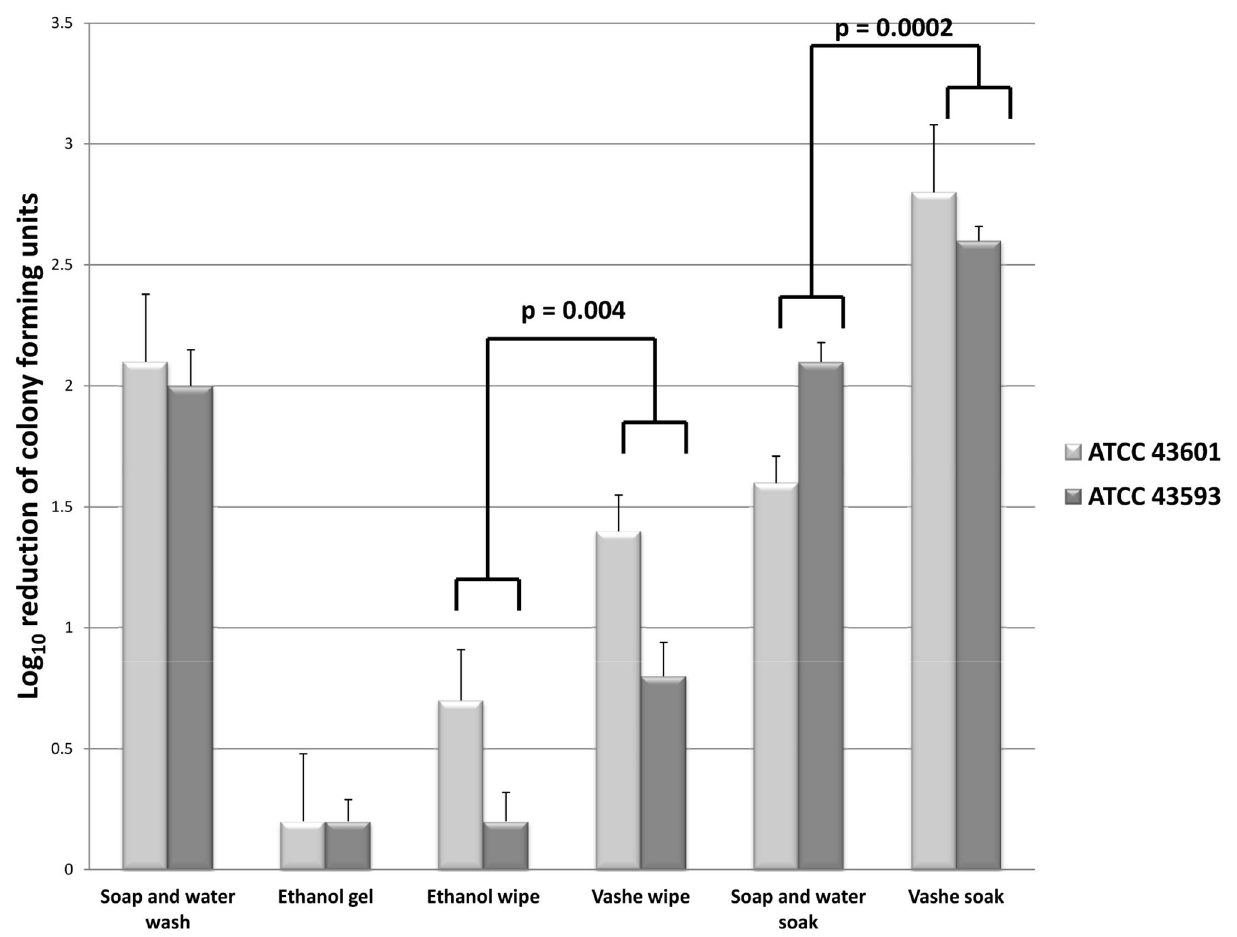
Figure 2. Effectiveness of Vashe for removal of C. difficile spores from hands. Mean log nontoxigenic Clostridium difficile from hands after performing different hand hygiene interventions. Hand hygiene interventions included alcohol hand gel, 2 mL of 0.05% triclosan liquid soap, 70% ethanol wipe, Vashe wipe, soap and water soak, and Vashe solution soak. For soaking experiments, contaminated hands were immersed in 1 gallon of Vashe solution or 1 gallon of water containing 10 mL of 0.5% triclosan liquid soap and massaged vigorously for 1 minute. Error bars represent standard error. doi: